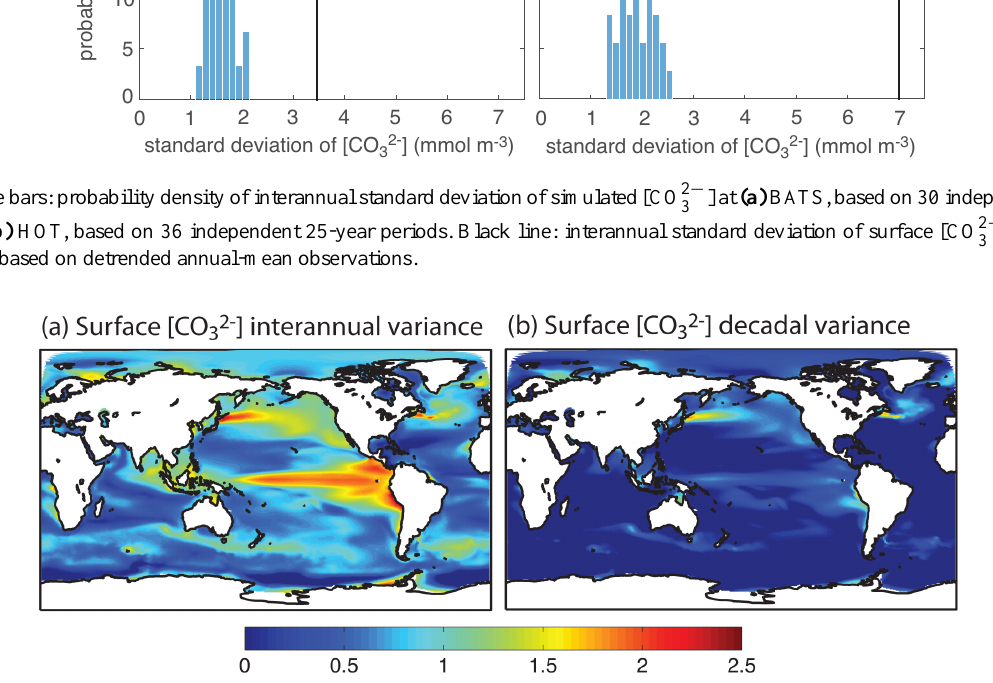
Figure 4. Variance in the surface ocean carbonate ion concentration for (a) annual-mean and (b) 10-year filtered model output (log 10 (mmolm − 3 ) 2